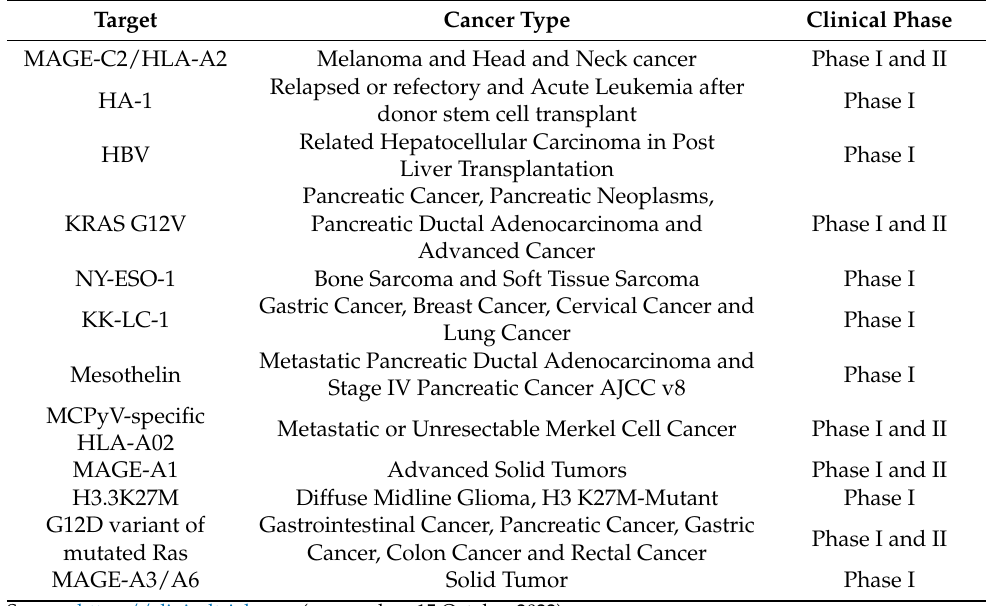
Table 1. Current TCR-based clinical